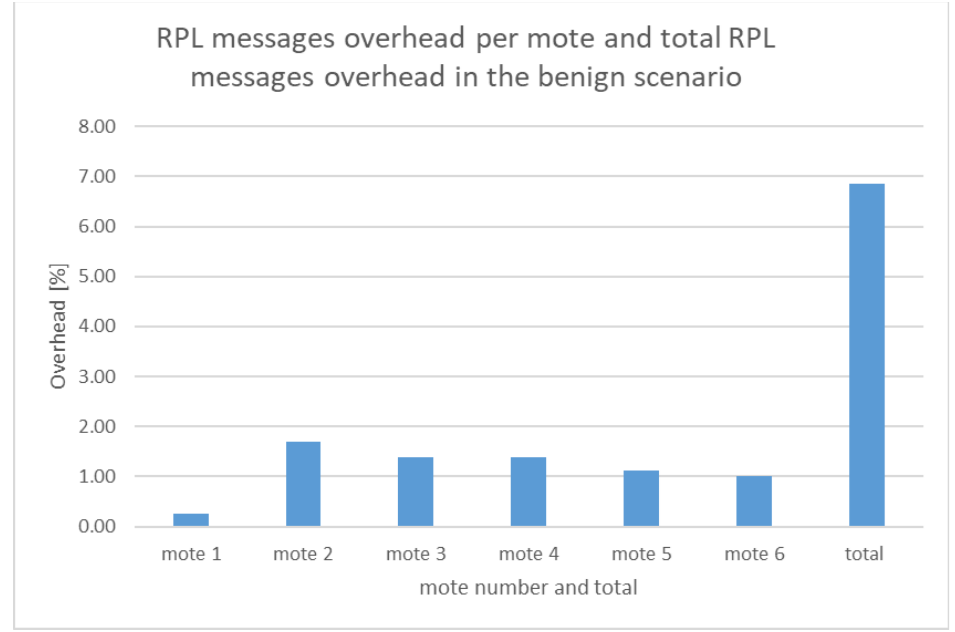
Figure 39. RPL messages overhead per mote and total RPL messages overhead in the benign sce- nario.